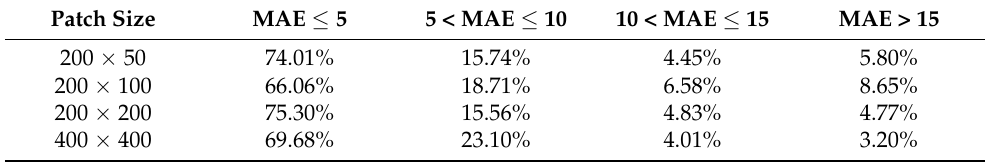
Table 3. The percentage of B-scans in different MAE